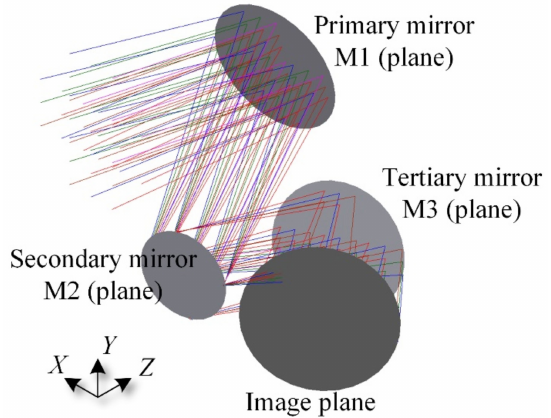
Figure 5. The layout of the nonsymmetric off-axis three-mirror initial plane